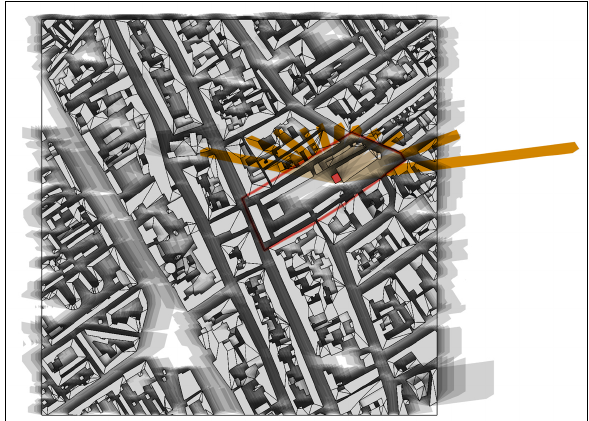
Figure 6. Single tall building case in uniform urban structure – Tower of Nieuwe Kerk in Delft (cityGML – LOD1), by: author